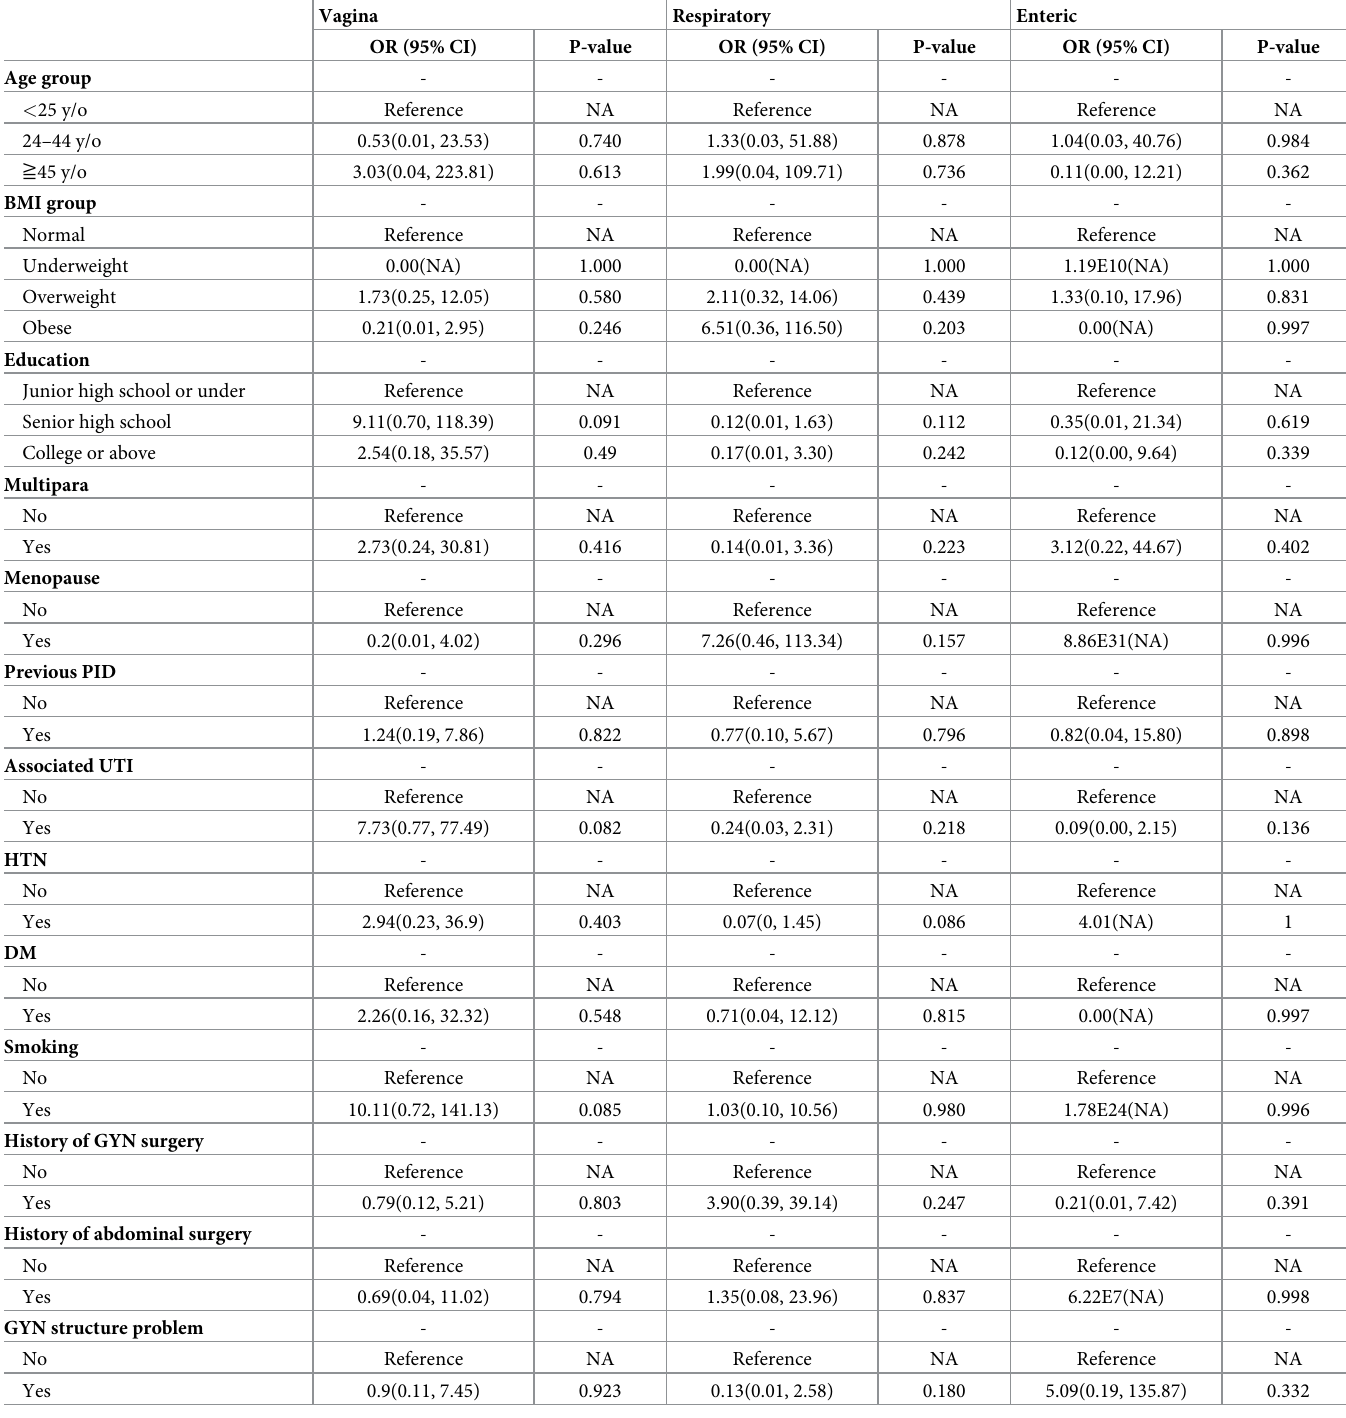
Table 4. Factors associated with vagina/respiratory/enteric infection (n =